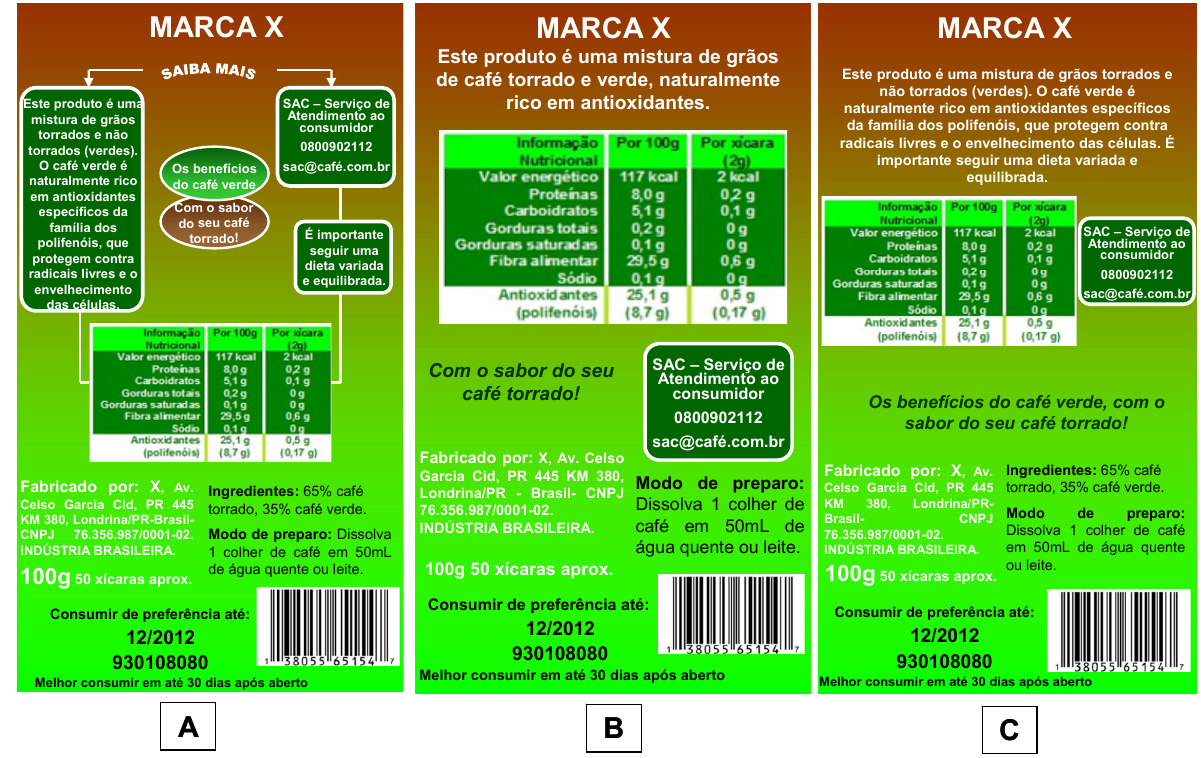
Figure 2. Back labels used in the preference ranking